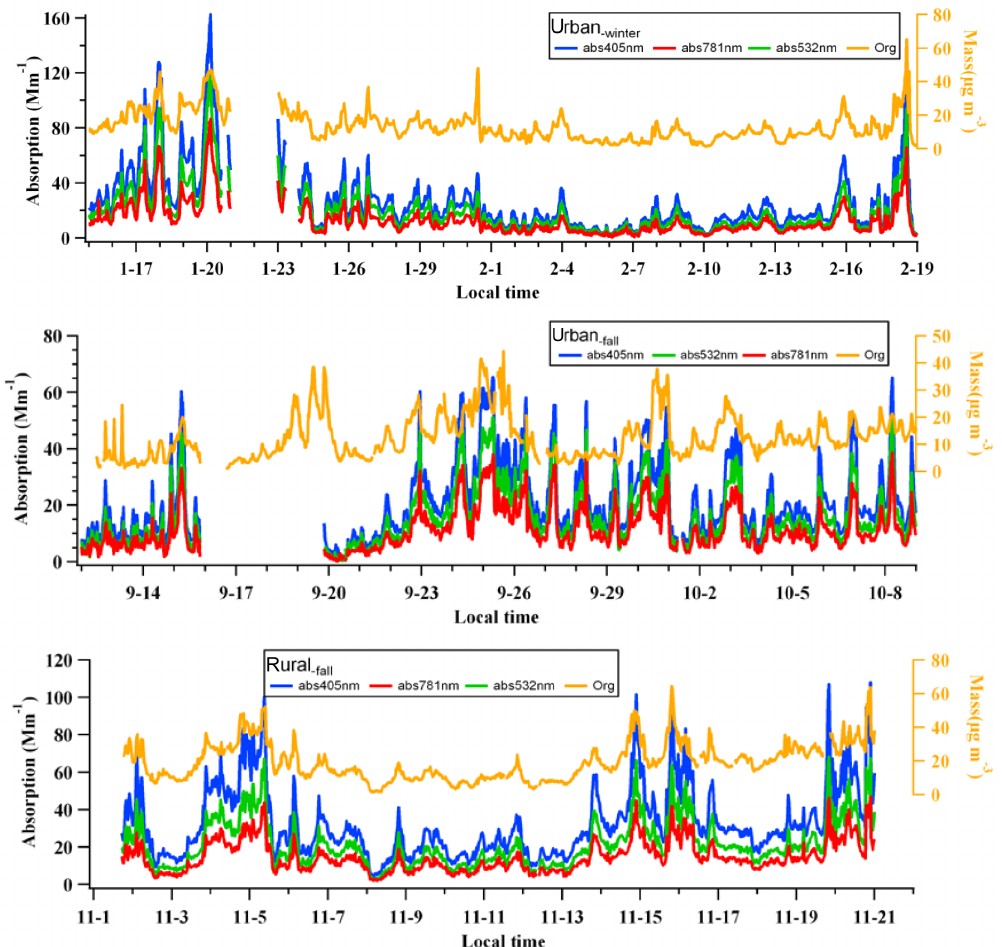
Figure 1. The time series of aerosol light absorption and mass concentration of organic aerosol in the different campaigns.